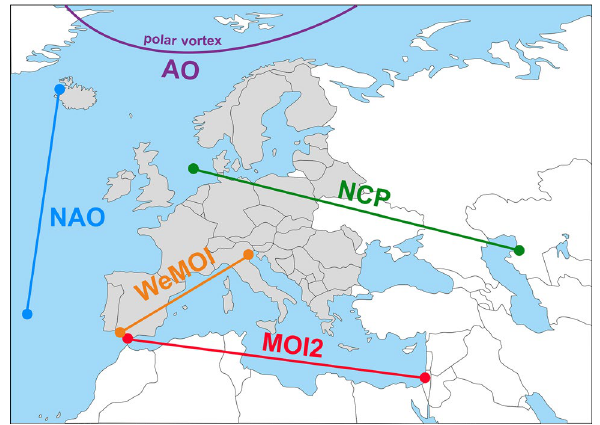
Figure 1. Geographical location of the precipitation area (39 European countries, coloured grey) and the five long-range air pressure indices studied in this paper. For NAO, NCP, MOI2 and WeMOI, the map shows the locations of reference points to calculate the air pressure differences. The AO is shown schematically as it is not defined by a point-to-point air pressure difference (see text). The geographical base map was retrieved